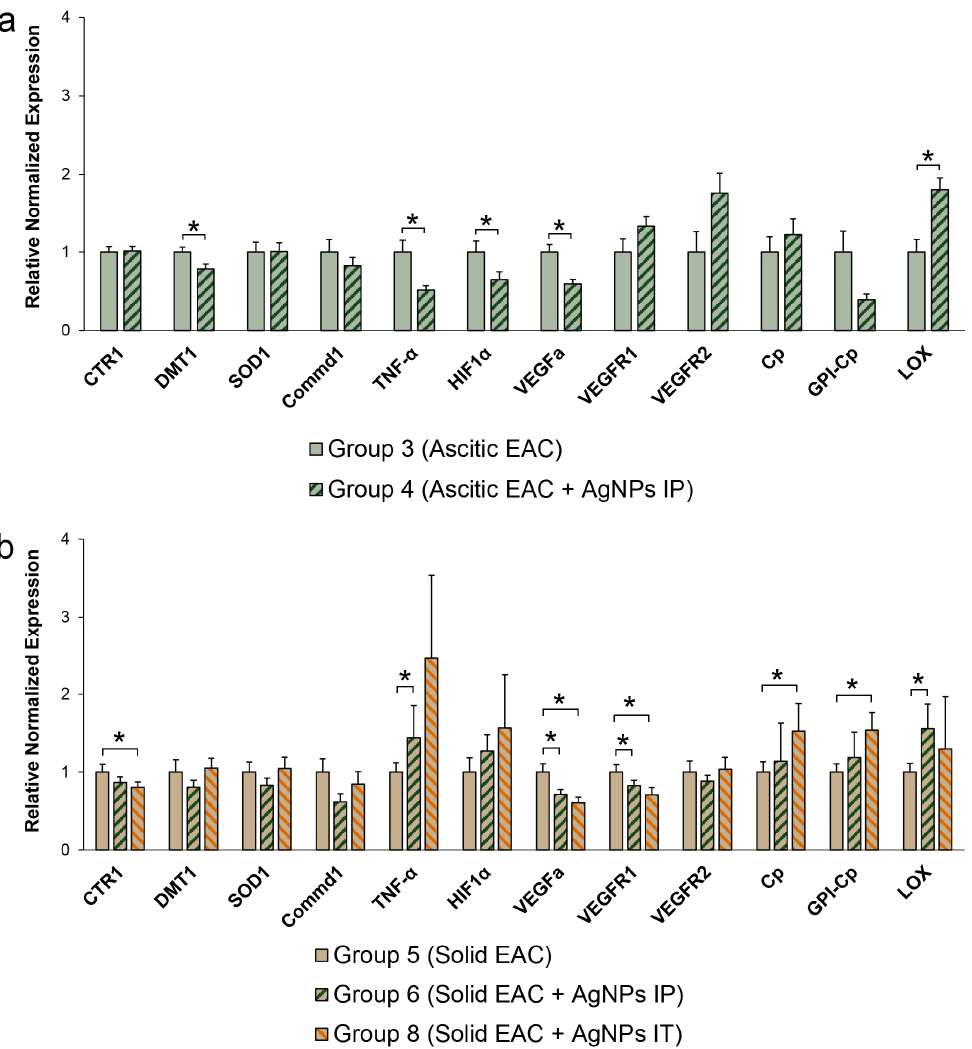
Figure 11. Copper-related genes profile expression in ascitic EAC ( a ) and solid EAC ( b ) treated with AgNPs. Numbering is the same as in Table 1. *: p < 0.05 compared to group 3 ( a ) or group 5 ( b